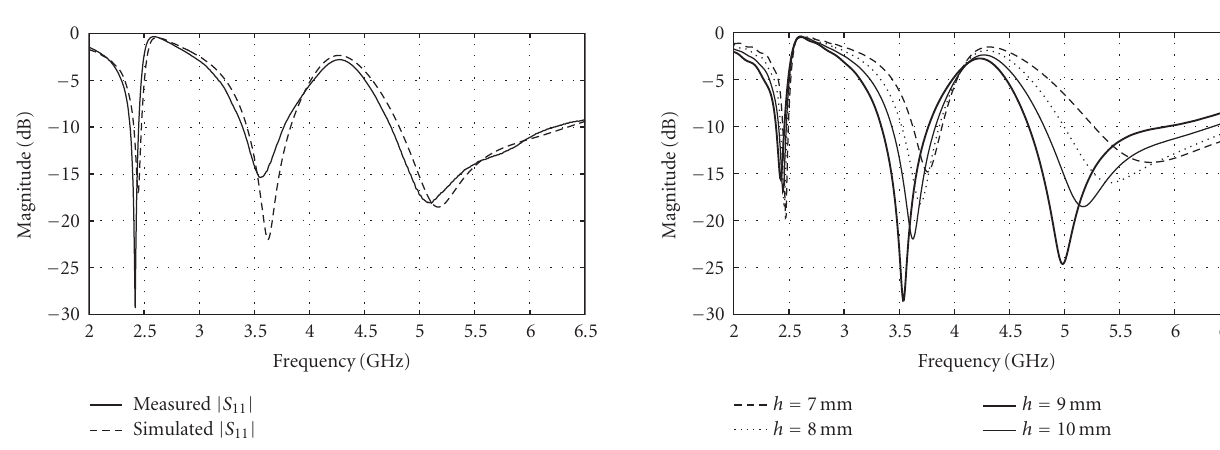
Figure 5: Simulated and measured reflection coe ffi cient of the tri- band antenna.